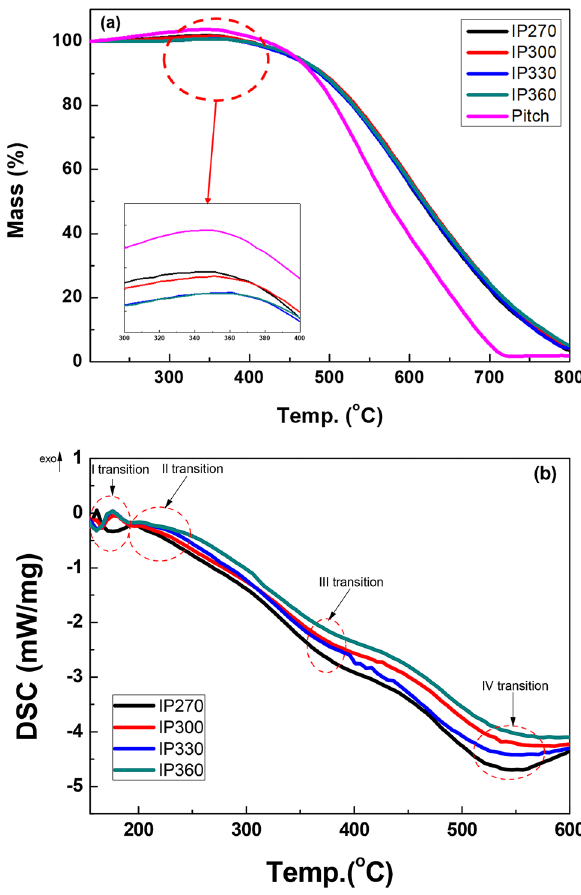
Figure 1. ( a ) TGA, ( b ) DSC results of the surface oxidized pitch at various surface oxidation